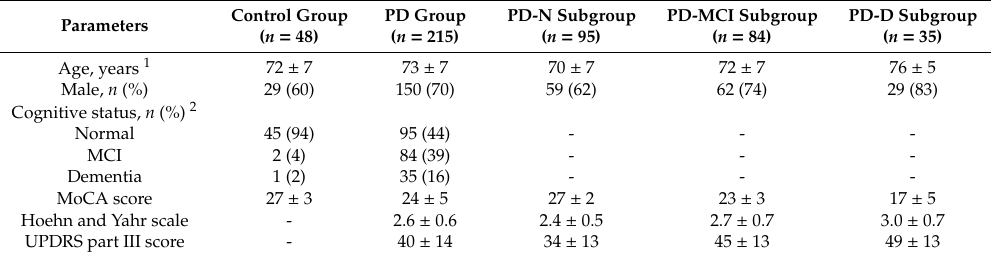
Table 1. Participant